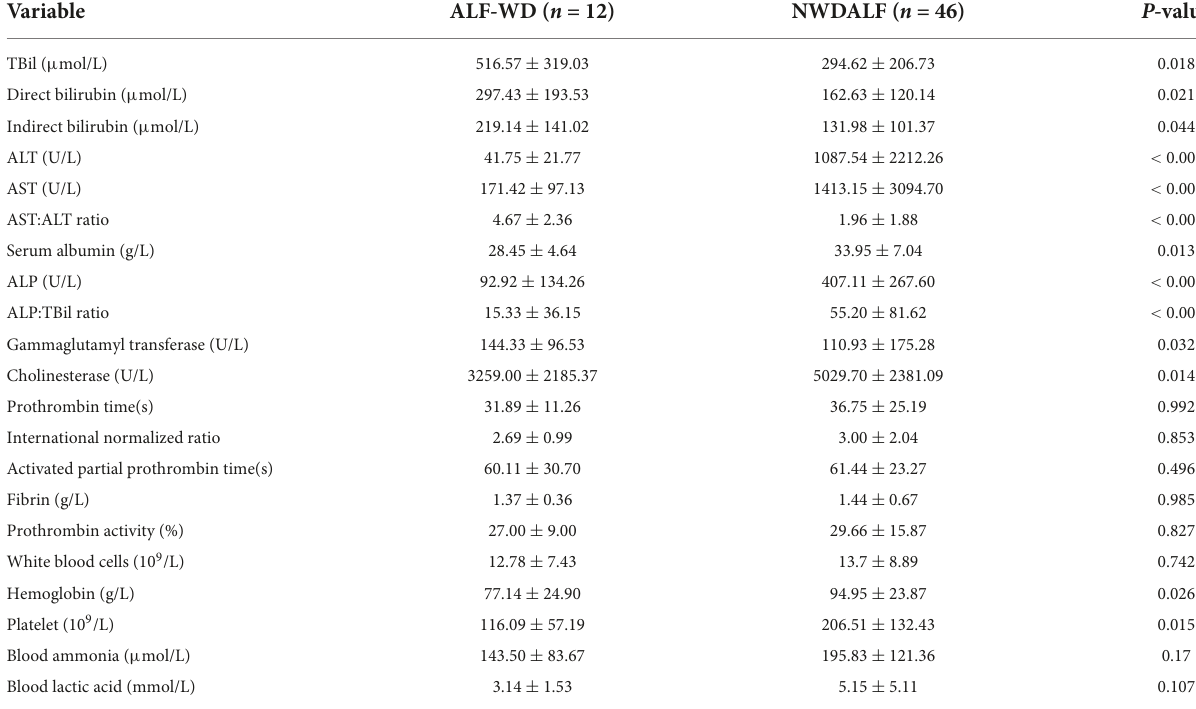
TABLE 4 Comparison of laboratory tests of children with ALF-WD or